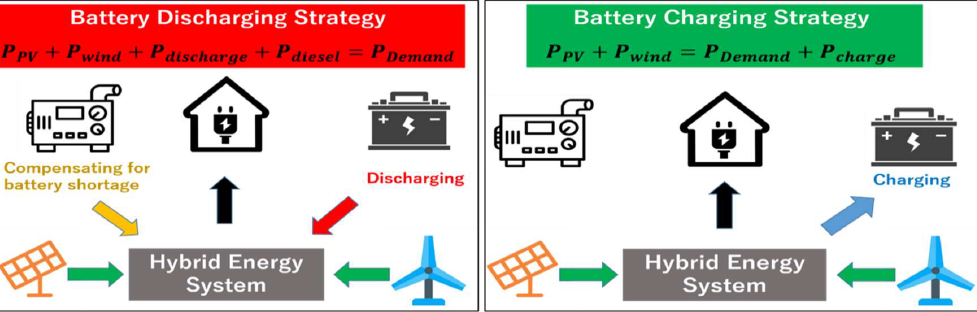
Figure 15. Demand–supply matching based on the battery charging / discharging modes.